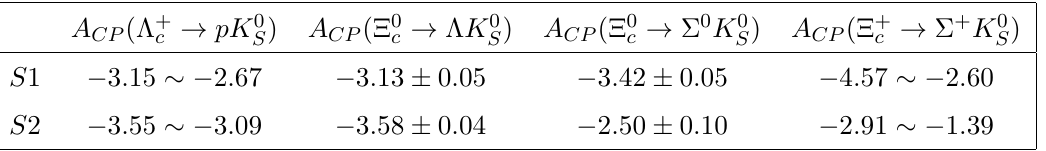
Table 3 . Time-integrated CP asymmetries A CP ( t 1 (cid:28) (cid:28) S (cid:28) t 2 (cid:28) (cid:28) L ) in B c ! B K 0 units of 10 (cid:0) 3 , where the sets of S 2 are obtained by (cid:13)ipping the signs of all phase parameters of S